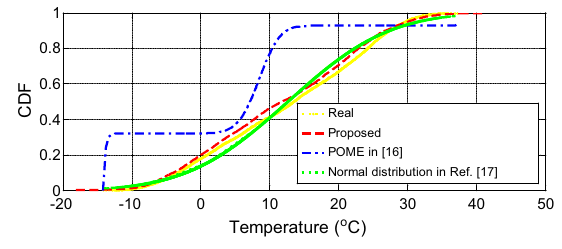
Fig. 5 CDFs of temperature simulated